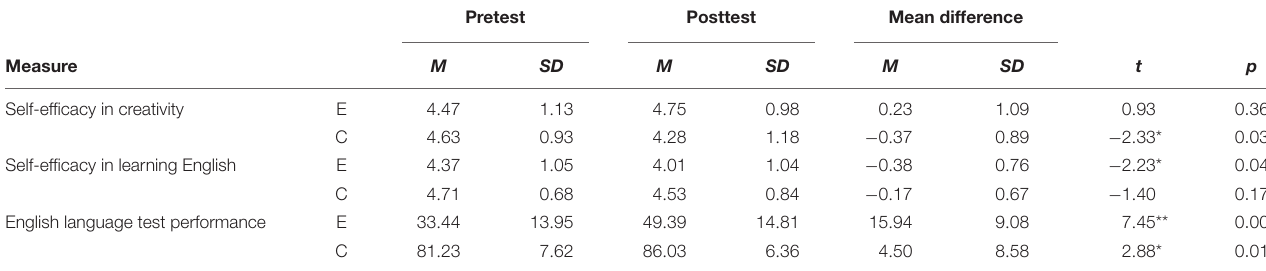
TABLE 2 | Pretest-posttest comparisons on learning outcomes.